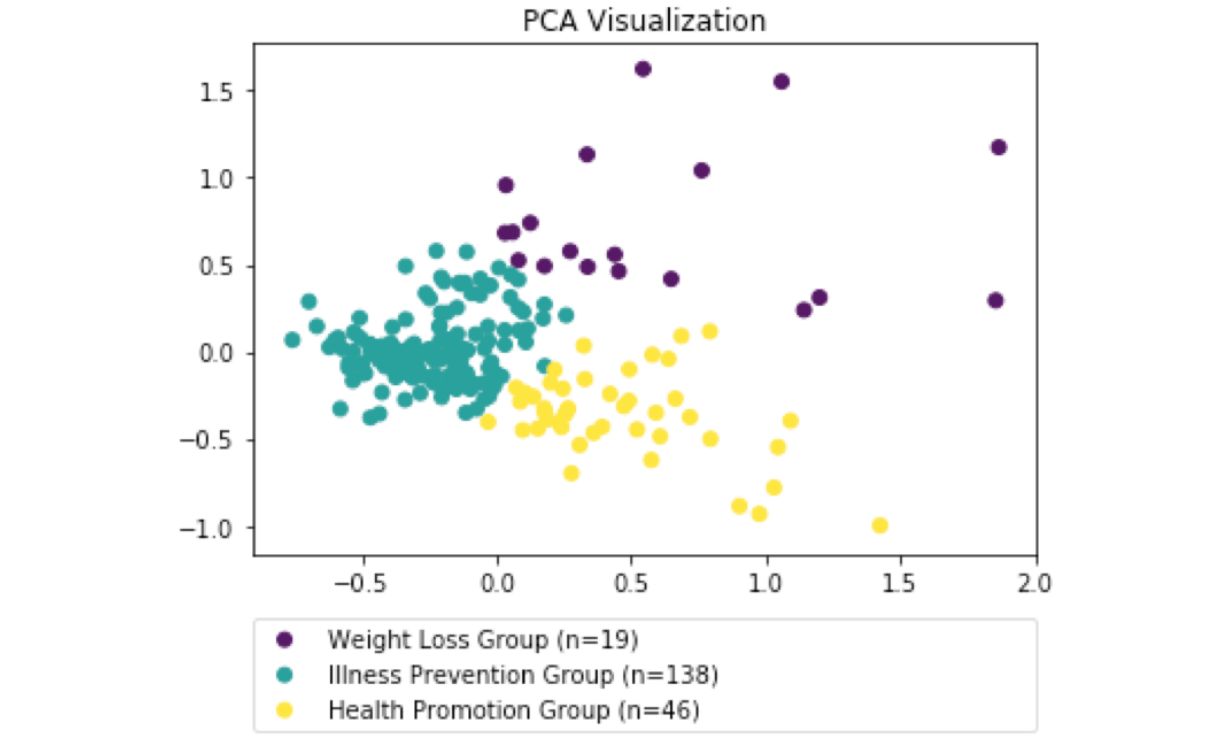
Figure 2. Principal Components Analysis (PCA) Visualization of motivational profiles. The plot axes represent the first two principal components of the bag-of-words vector representations of the motivations given by patients. The purple cluster corresponds to the responses of patients who listed weight loss as their sole motivation for physical activity, the teal cluster corresponds to patients who were primarily motivated by illness prevention, and the yellow cluster corresponds to those patients primarily motivated to do physical activity due to health